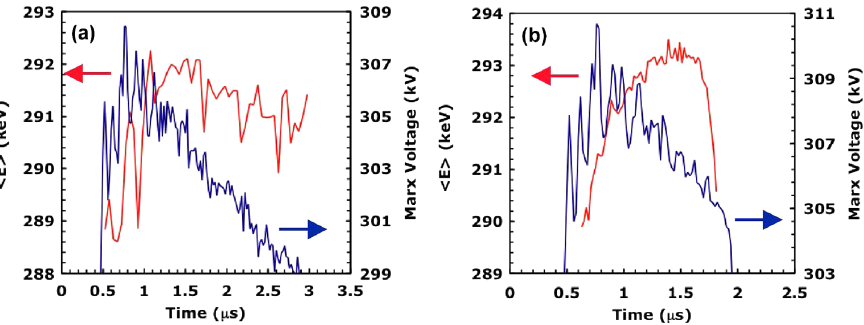
FIG. 10. Correlation of the Marx voltage (blue) with the h E i (red) resolved from longitudinal phase space measurements with: (a) the streak camera for a 3 (cid:1) s pulse; and (b) the slit cup for a 2 (cid:1) s pulse (note scale differences).